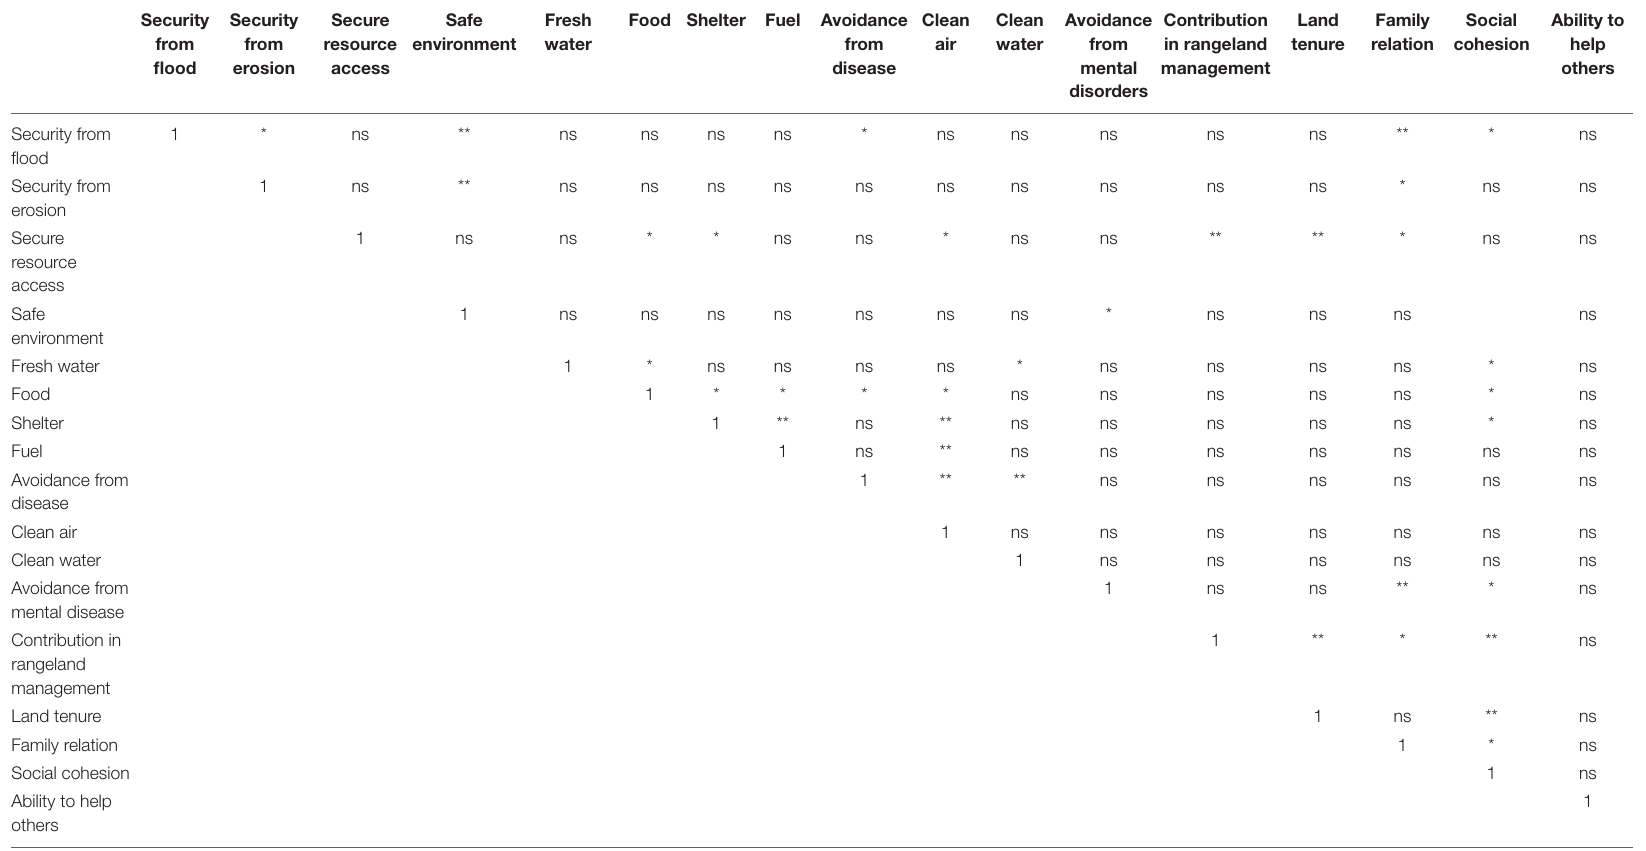
TABLE 4 | Correlations between the well-being indices based on their importance for ecosystem services.